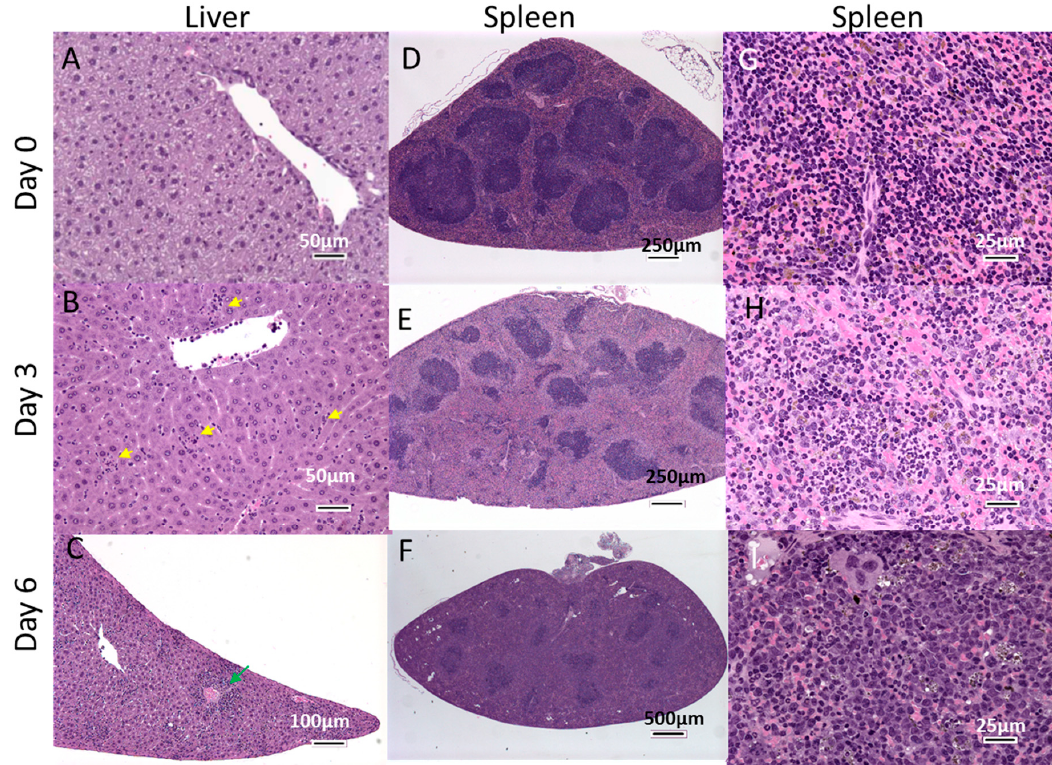
Figure 6. H&E Staining of Liver ( A – C ) and Spleen ( D – I ) following EBOV Challenge. Mice were 1.0 × 10 2 pfu of EBOV and 6 mice were euthanized each day from Day 0 (unchallenged) through challenged with 1.0 × 10 2 pfu of EBOV and 6 mice were euthanized each day from Day 0 Day 6. Panels A , B and C show representative liver sections from mice euthanized on Days 0, 3 and 6 (unchallenged) through Day 6. Yellow arrowheads indicate focal sinusoidal inflammation in liver, respectively. Representative spleen sections are shown in panels D , E and F . Panels G , H and I show the green arrowhead shows perivascular inflammation. spleen sections at a higher magnification. Yellow arrowheads indicate focal sinusoidal inflammation in liver, green arrowhead shows perivascular